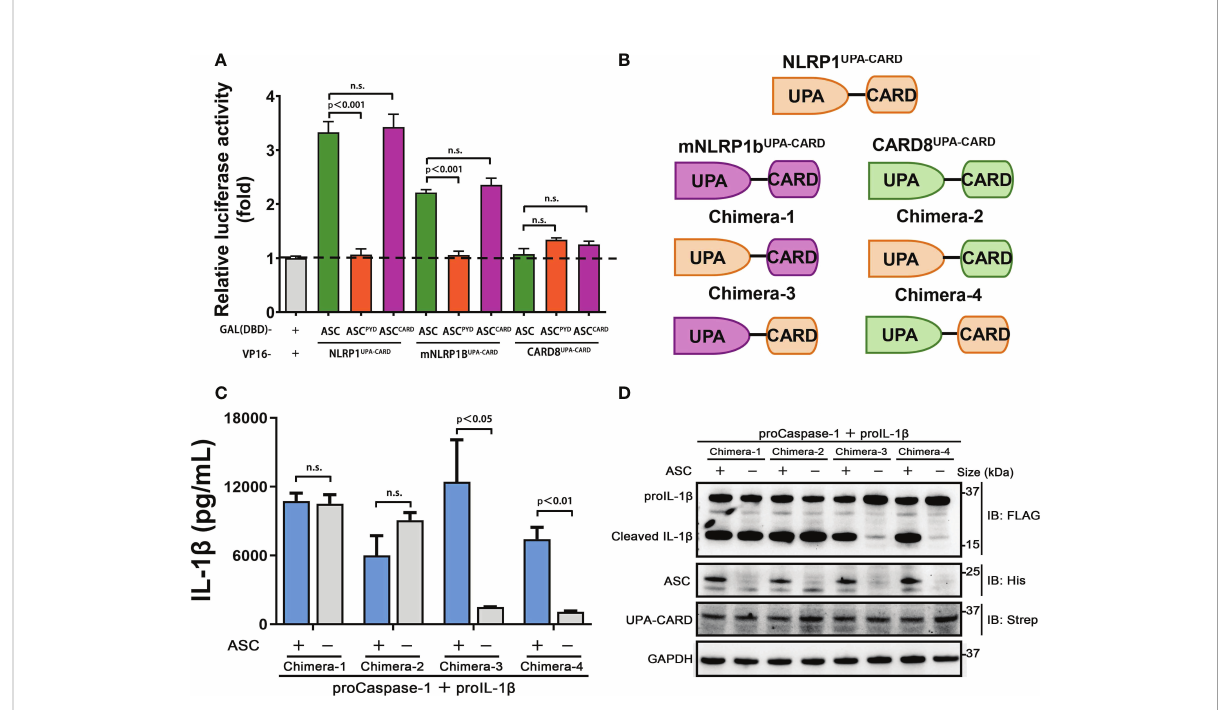
FIGURE 4 CARDs play the key roles for ASC dependence in NLRP1 and CARD8 in fl ammasome. (A) Mammalian two-hybrid characterization for the interaction of ASC with NLRP1 UPA-CARD , mNLRP1b UPA-CARD and CARD8 UPA-CARD . Luciferase activity was normalized to Renilla and data were shown as the fold of empty vector control. Mean values ± SEM are representative of three biological replicates. (B) Diagram of the chimera proteins of NLRP1 UPA-CARD , mNLRP1b UPA-CARD and CARD8 UPA-CARD . (C,D) ELISA and immunoblotting analysis were conducted from ASC- de fi cient chimera in fl ammasome. Data are shown as mean ± SEM and representative of three biological replicates. n.s., not signi fi